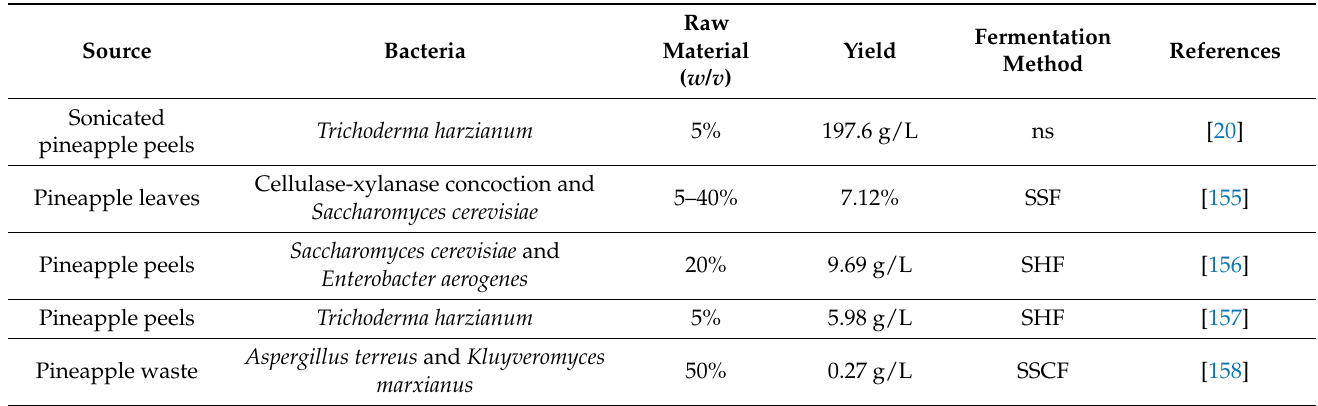
Table 5. Summary of works of literature on bioethanol production from pineapple